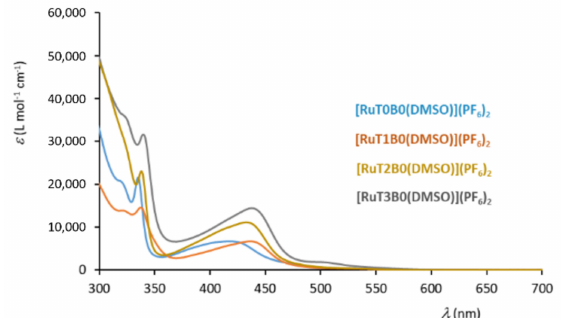
Figure 8. UV-visible spectra in acetonitrile for the four Ru-DMSO (S)